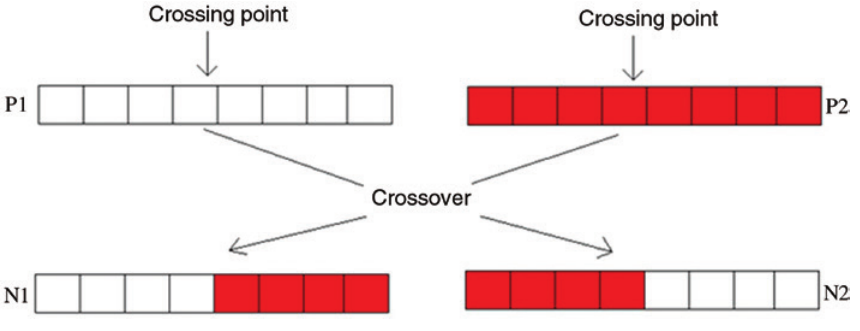
Figure 2: Crossover